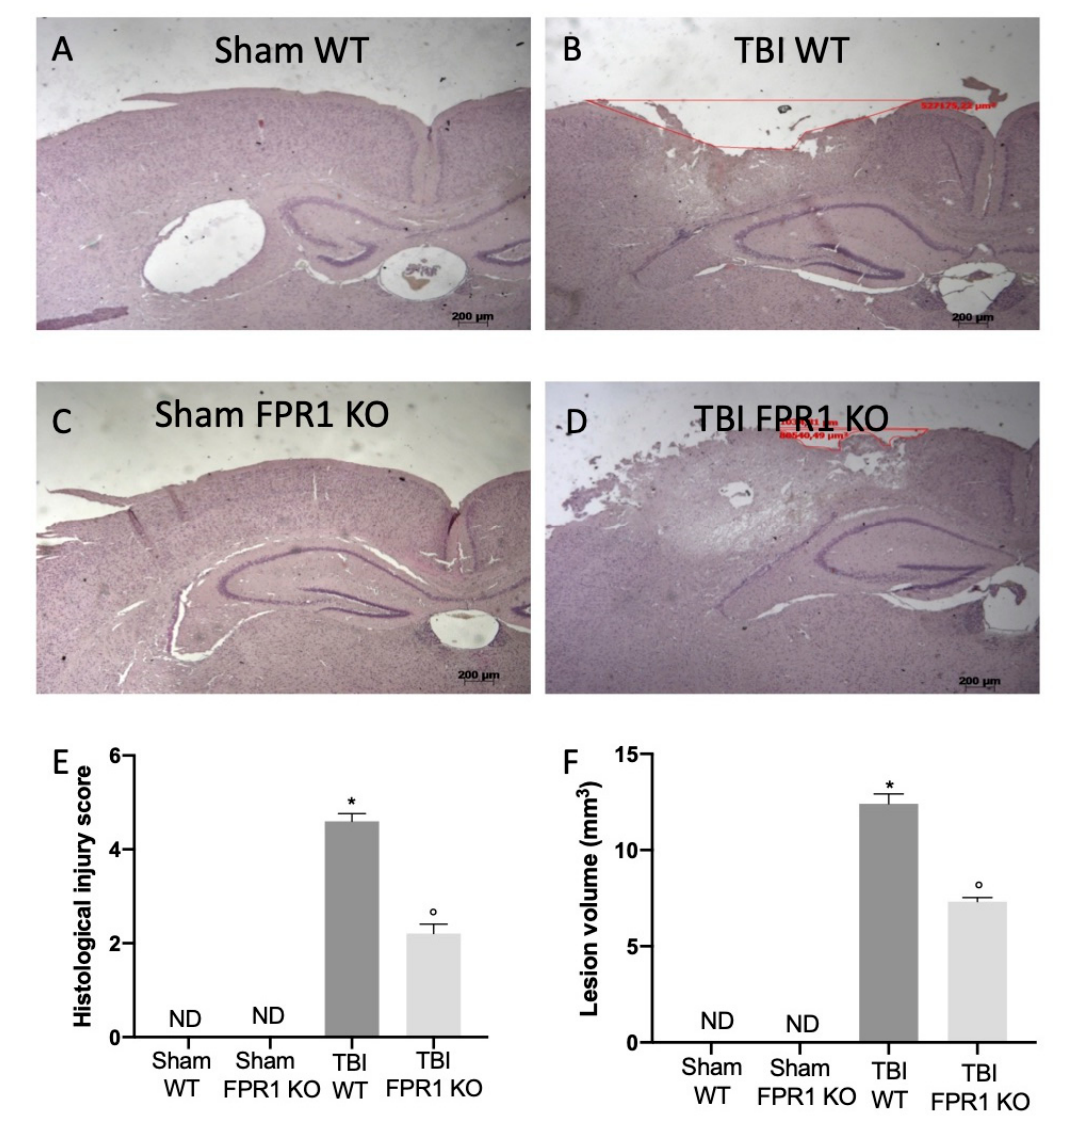
Figure 1. Effect of the absence of Fpr1 on histological alterations: Histological analysis shows no alteration in brain section from mice of the Sham WT group ( A ) and Sham Fpr1 KO group ( C ). Traumatic brain injury (TBI) WT group 24 h after injury displays evident tissue inflammation and disorganization in the perilesional area ( B ). ( D ) Fpr1 KO animals subjected to TBI show a significant reduction in the injury compared to the TBI WT group ( E ). Moreover, the TBI Fpr1 KO group displays a reduced lesion volume compared to TBI WT group as show in ( F ). For the analyses, n = 5 animals from each group were employed. Results were analyzed by two-way ANOVA followed by a Bonferroni post-hoc test for multiple comparisons. Non-parametric data were analyzed with Fisher’s exact test. * p < 0.05 vs. Sham WT; ° p < 0.05 vs. TBI WT. scale bar 200 μ m.